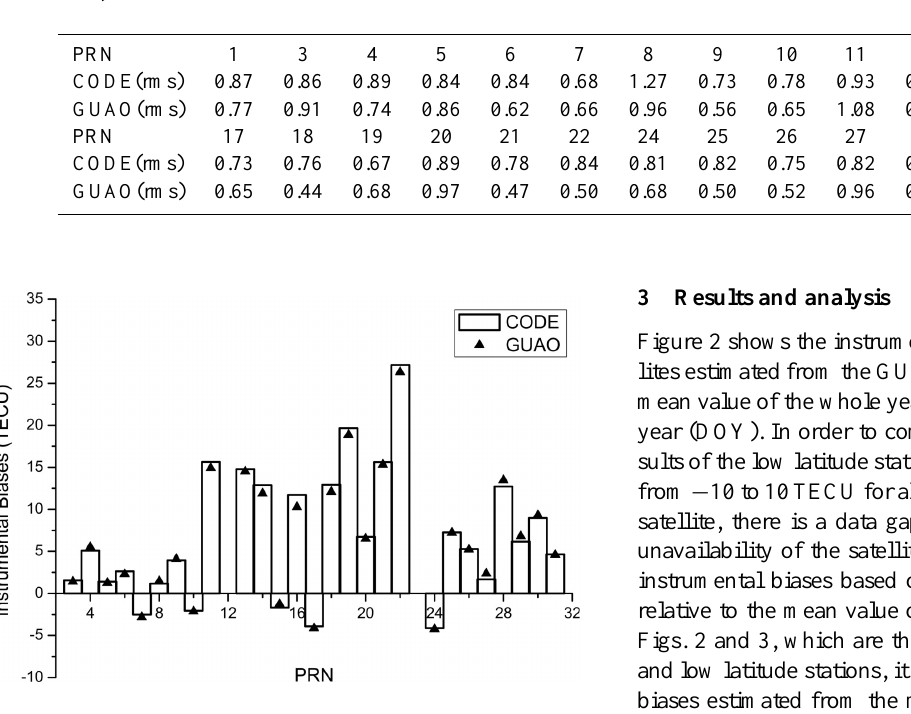
Table 2. The RMS of the satellite instrumental bias obtained from CODE and estimated using SCORE method based GUAO data over 2004 (unit: TECU).